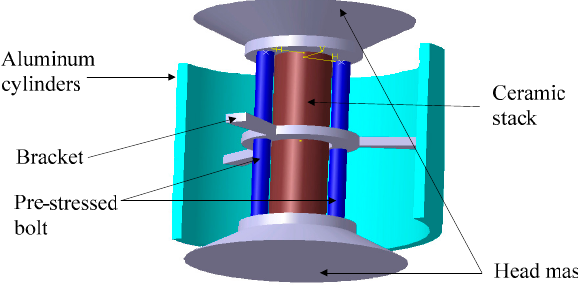
Figure 1. The structure of the transducer.